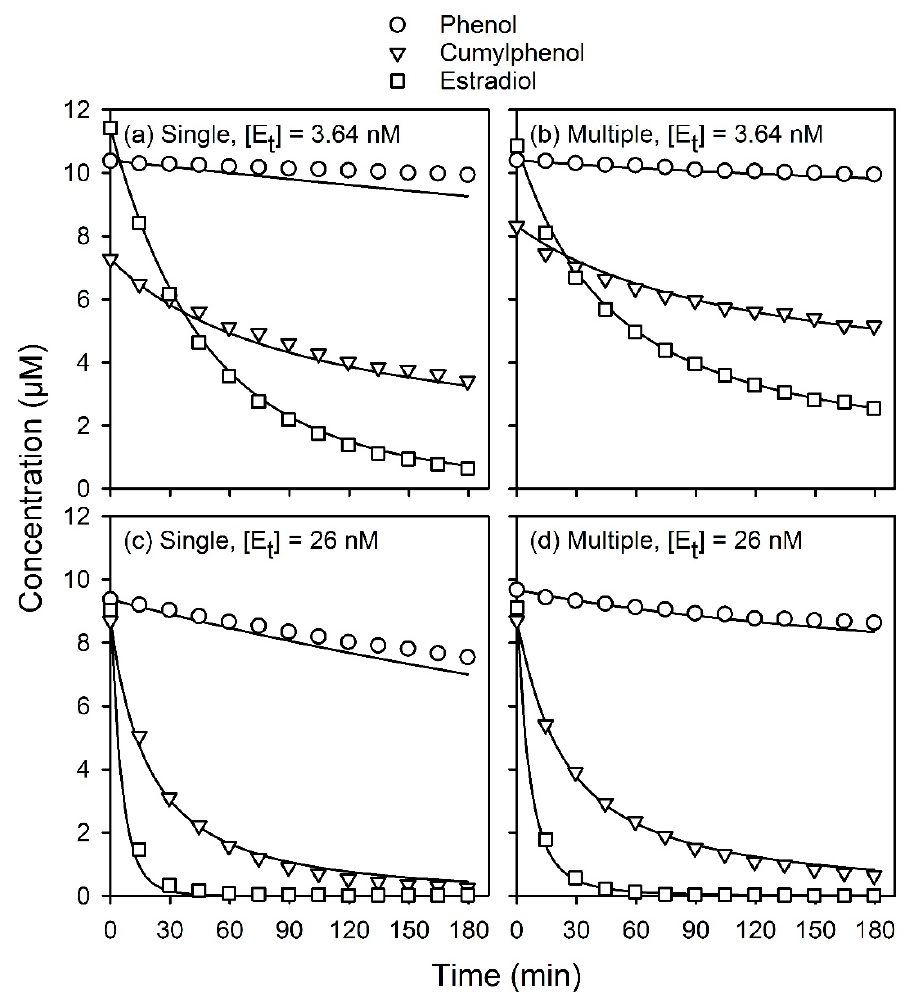
Figure 4. Experimental measurements (symbols) and model predictions (lines) for the laccase-catalyzed oxidation of phenol, cumylphenol, and estradiol over a 3-h reaction period: ( a ) oxidation of individual substrates using 3.64 nM laccase; ( b ) oxidation of a mixture of all three substrates using 3.64 nM laccase; ( c ) oxidation of single substrates using 26 nM laccase; ( d ) oxidation of a mixture of all three substrates using 26 nM laccase.